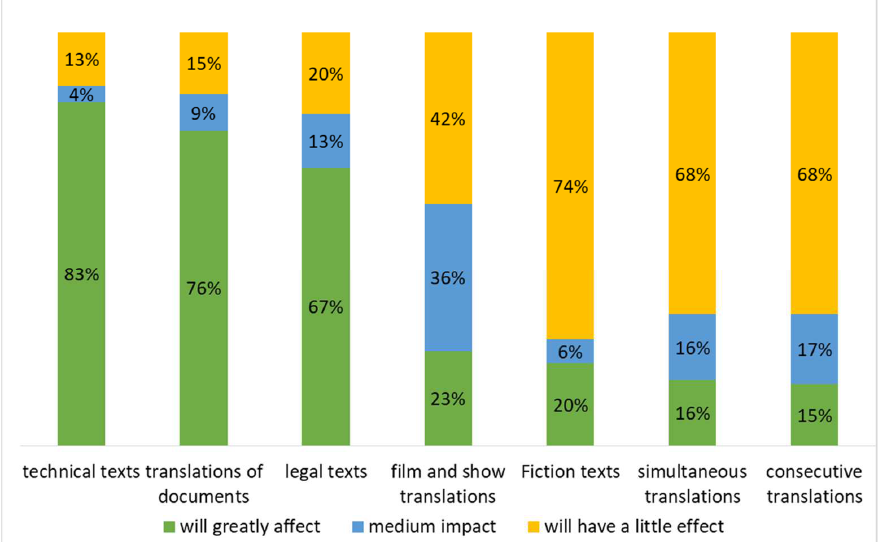
Figure 9. Which type of translation will be most affected by AI? N = 101.